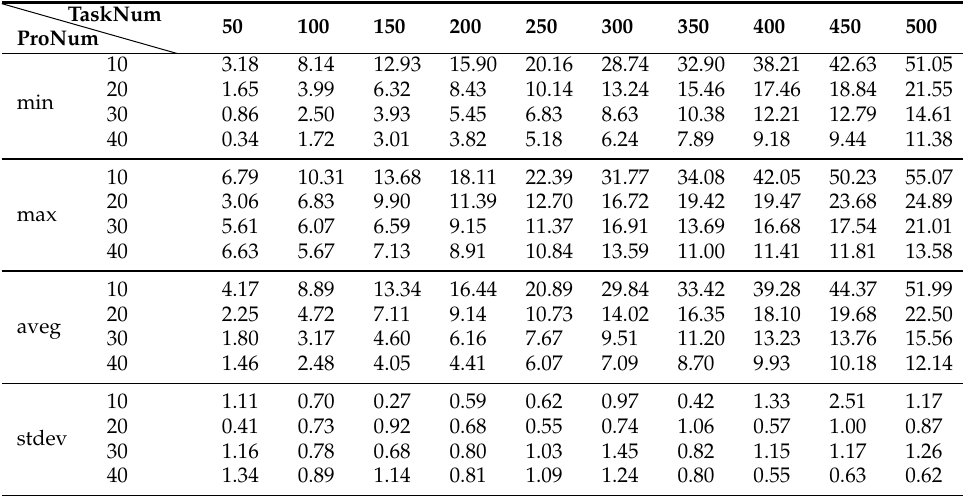
Figure 12. The load balancing tests when the number of processors is 10, 20, 30, and 40. Table 1. The analysis of test results